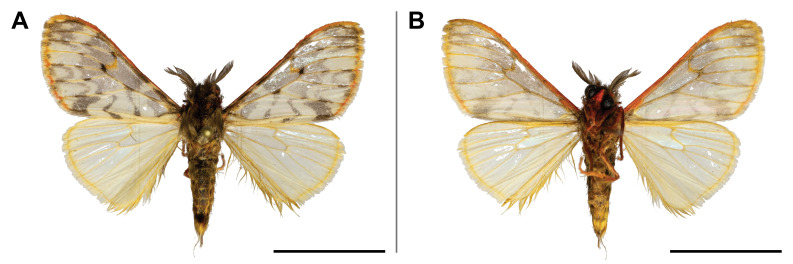
Rhypopteryx
rubripunctata (Weymer, 1892). A. dorsal view; B. ventral view. The scale bar represents 1 cm.